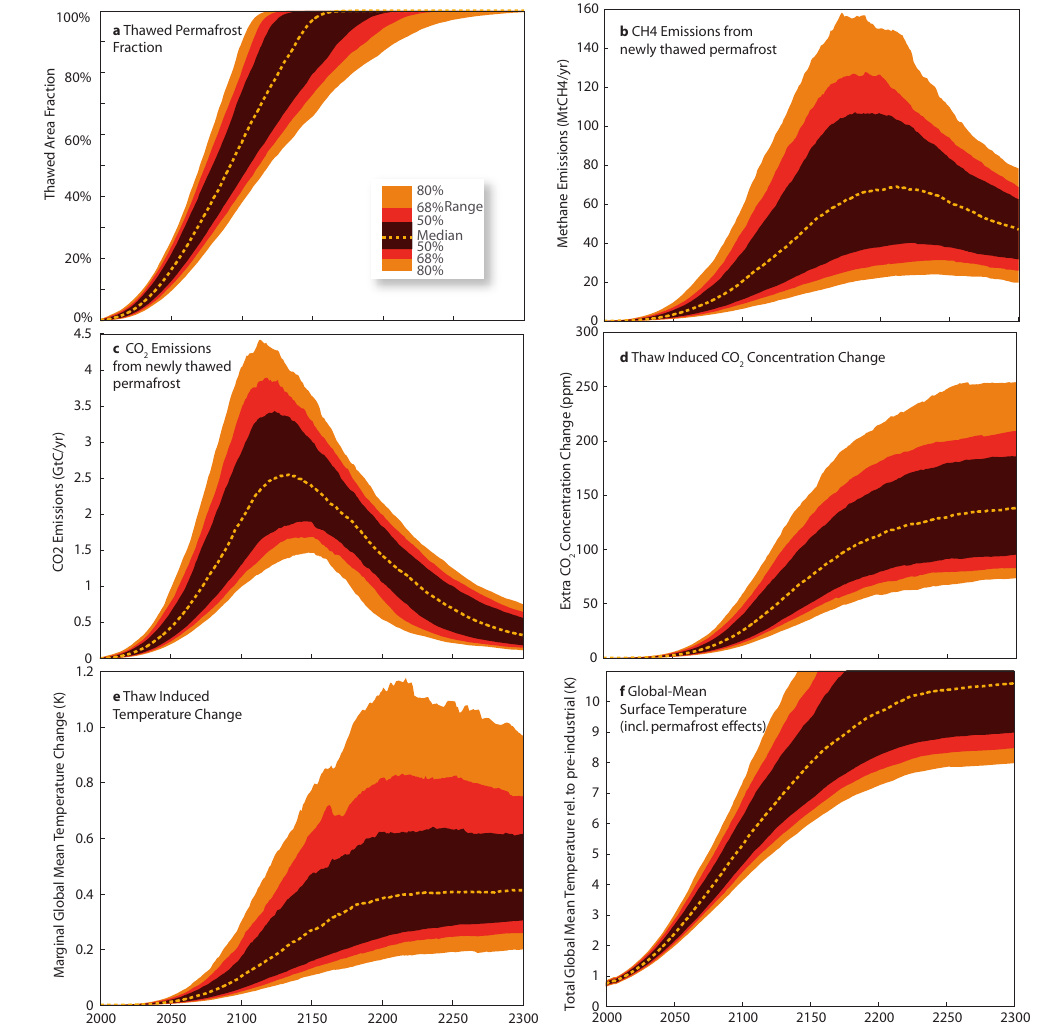
Fig. 3. This study’s estimated ranges of thawed permafrost fraction (a) , methane (b) and CO 2 emissions (c) from carbon in newly thawed permafrost soils, thaw induced CO 2 concentration (d) and temperature change (e) , and the total anthropogenically induced global mean temperature anomaly (f) . Results were obtained from an uncertainty analysis for the RCP8.5 scenario. The uncertainty ranges results from 2400 member ensemble simulations, using a Monte Carlo sampling that combines the joint distribution of 82 climate model parameters, 9 sets of 17 carbon cycle parameters and 22 independently sampled parameters of our permafrost model (see text and Table